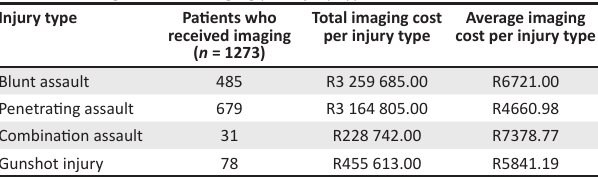
TABLE 4: Average costs of imaging per injury type. Injury type Patients who received